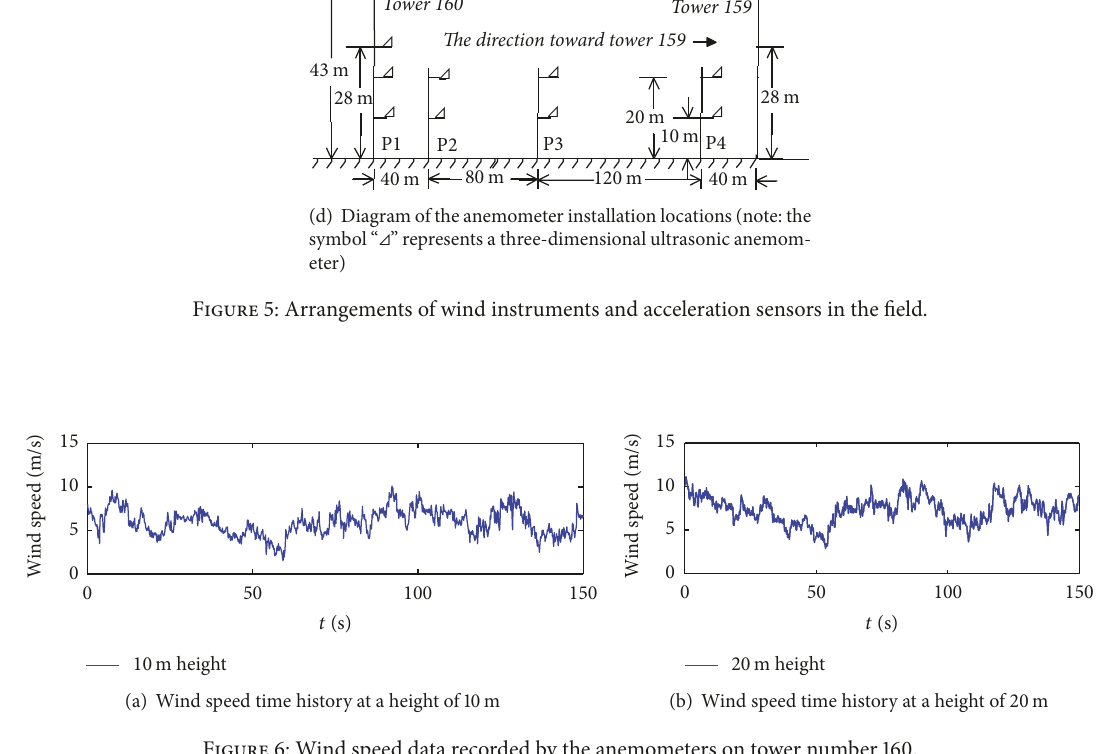
Figure 6: Wind speed data recorded by the anemometers on tower number